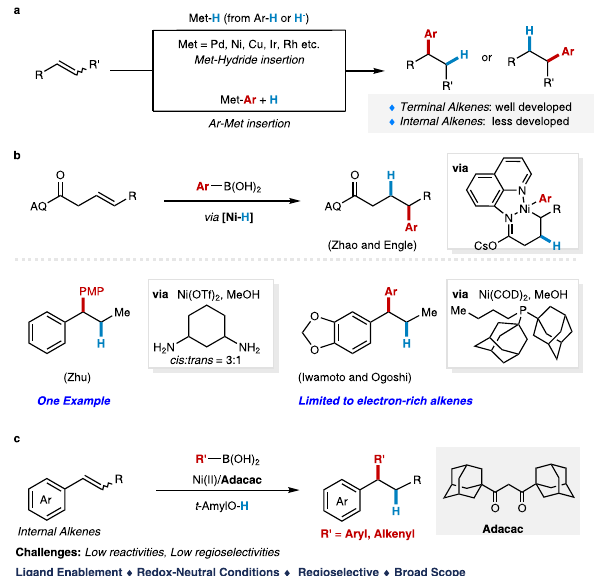
Fig. 1 | Synopsis for Ni-catalyzed hydroarylation and hydroalkenylation of internal alkenes. a Transition-metal catalyzed hydroarylation of alkenes. b Ni- catalyzed hydroarylation of internal alkenes with arylborons. c Ligand enabled Ni- catalyzed hydroarylation and hydroalkenylation of internal alkenes with organo- borons. Ar aryl, PMP p -methoxyphenyl.